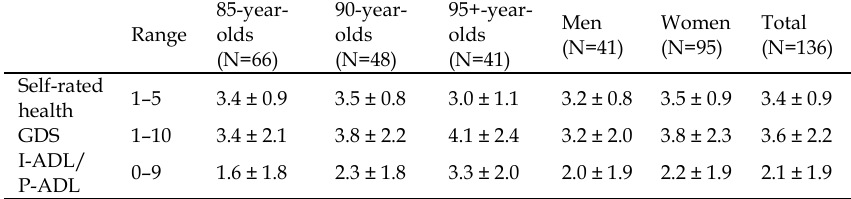
Table 1. Distribution (mean ± SD) of the health variables: self-rated health, GDS and